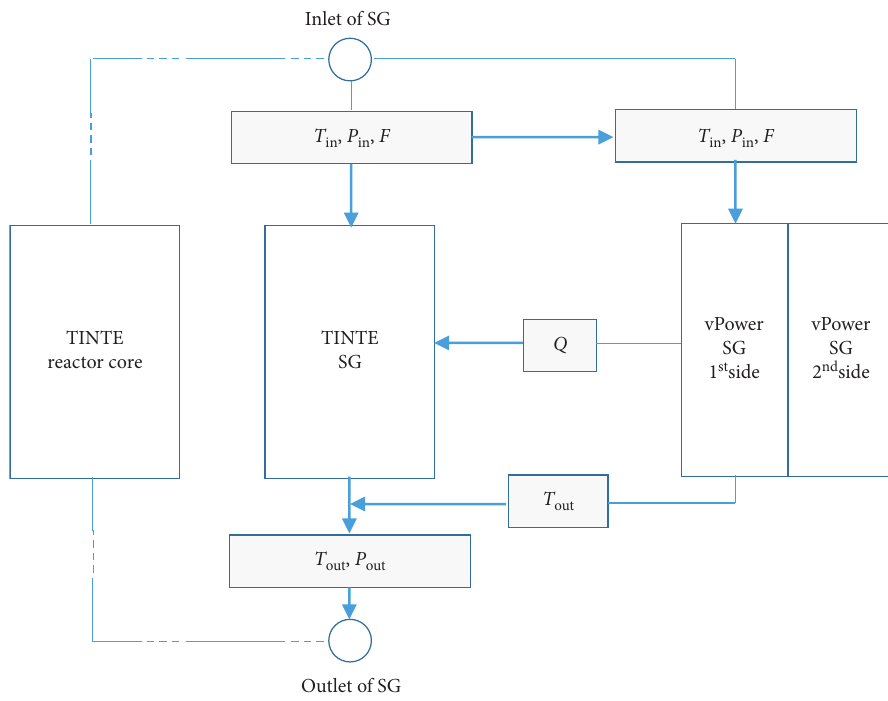
Figure 8: Coupling and data communication between TINTE and vPower.